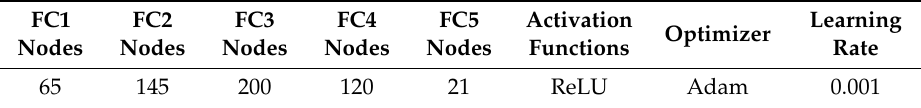
Table 2. The parameter setting of the actor